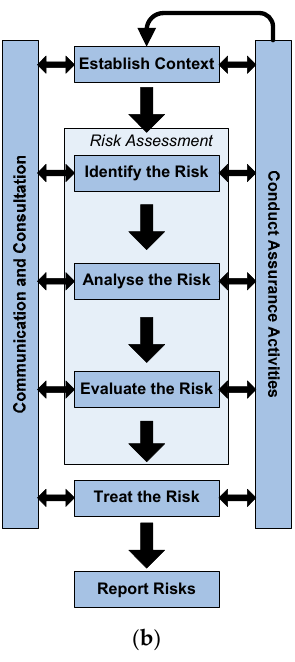
Figure 7. Risk management framework commonly adopted within the railway industry: ( a ) risk management process; ( b ) risk assurance policy development. The processes are in accordance with ISO31000. Ongoing risk management within a business unit is carried out through risk assessment and maintenance of operational, project, and safety risk registers. The direct and indirect risk